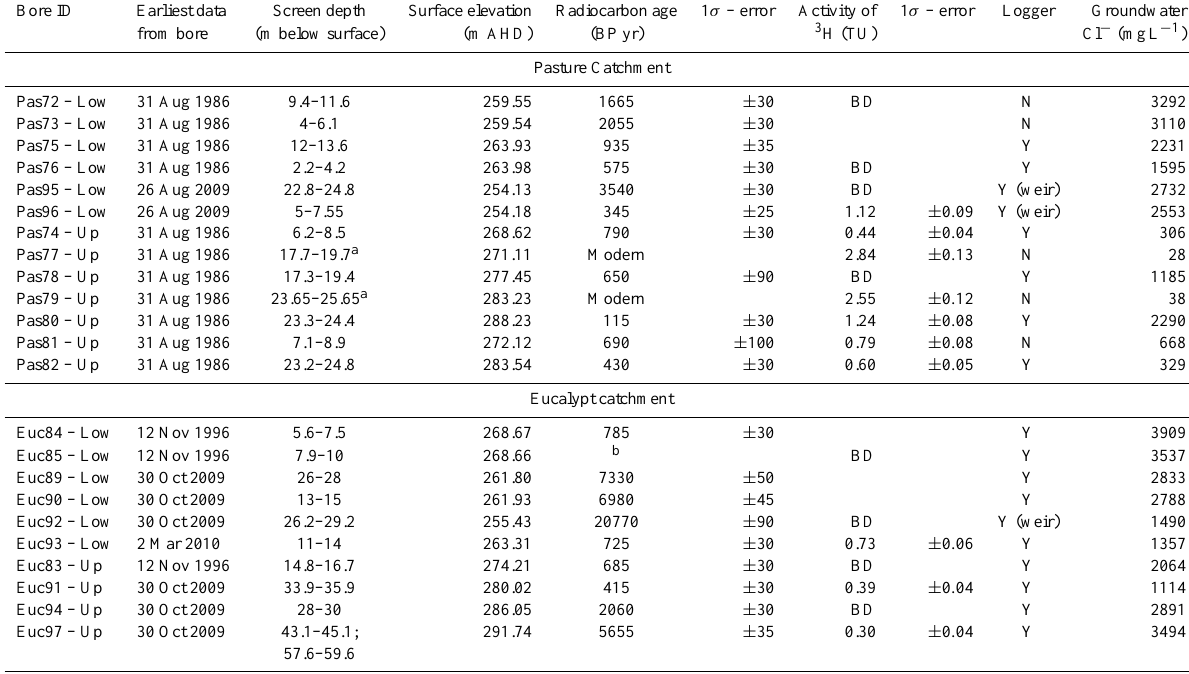
Table 1. Groundwater characteristics and bore construction. Bore